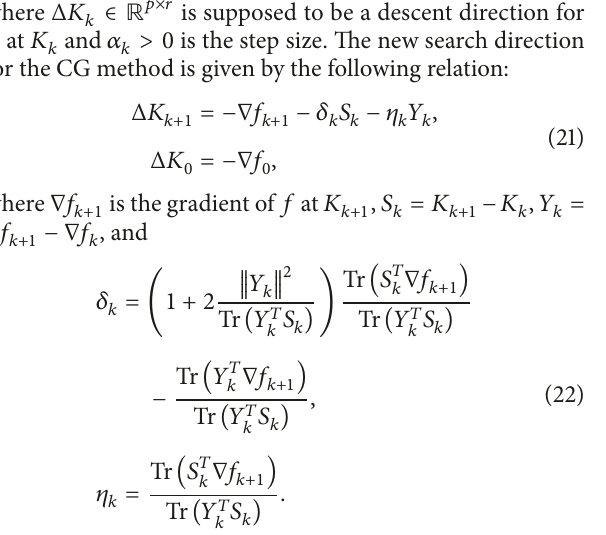
Algorithm 7 (three-term CG method for the output feedback